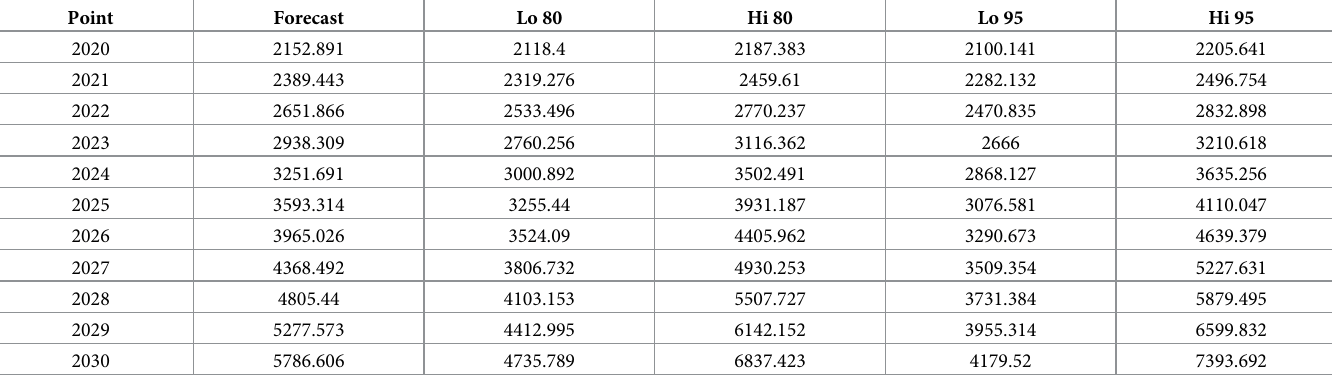
Table 6. Forecast value for GNI using ARIMA